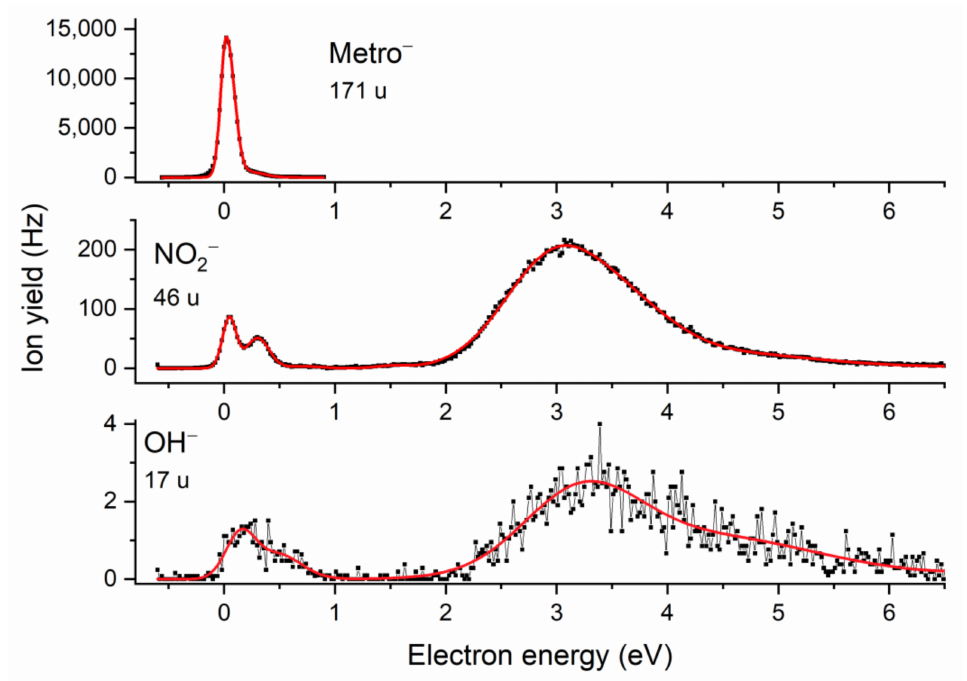
Figure 3. The anion efficiency curves for the Metro parent radical anion Metro − (top), NO 2 − (middle), and OH − (bottom) upon electron attachment to isolated